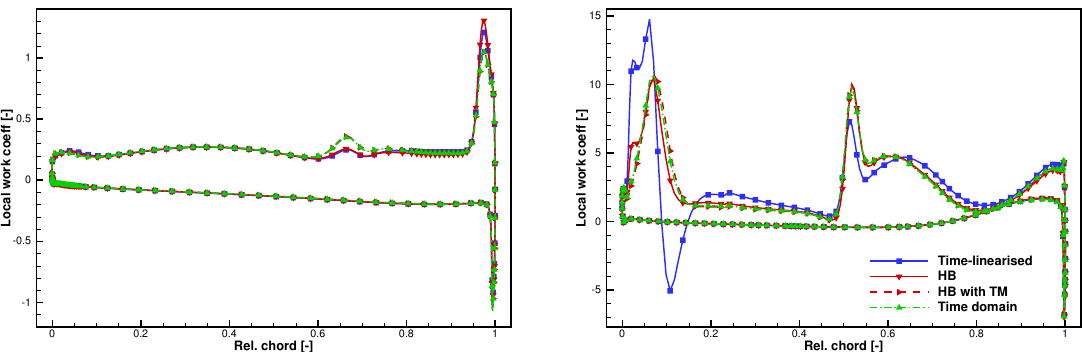
Figure 10. Local work coefficient for σ = − 72 ◦ predicted by time-domain, harmonic balance, and time- linearised solvers at 50% ( left ) and 90% ( right ) channel height.